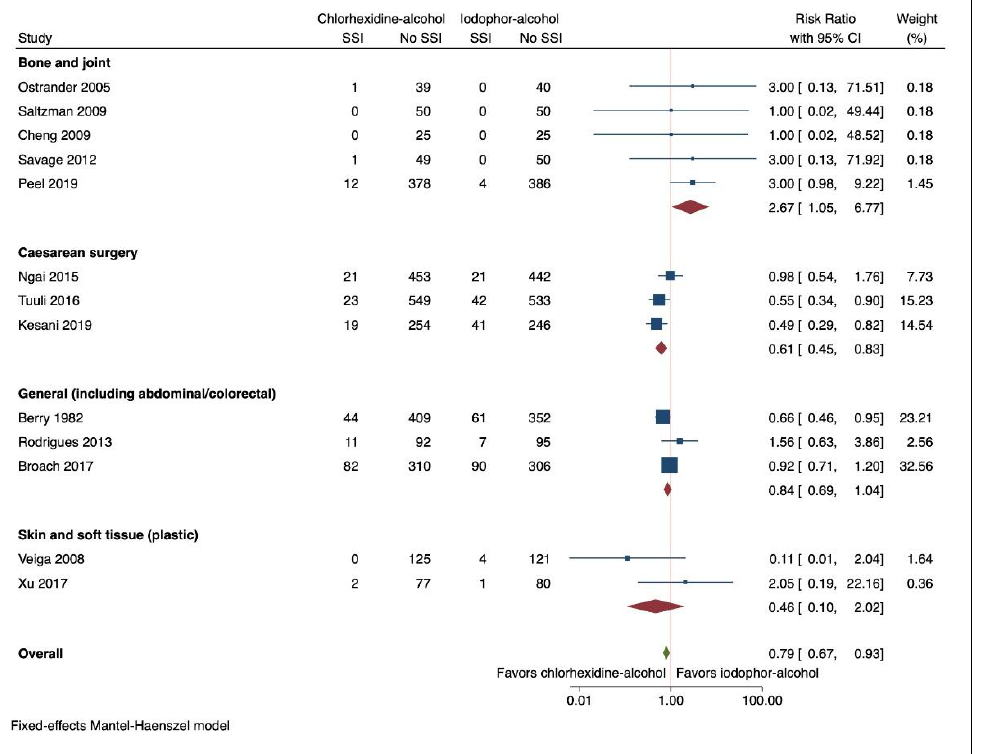
Figure 3 . Forest Plot Comparing Risk of Surgical Site Infection (SSI) with Chlorhexidine-Alcohol to Iodophor-Alcohol Surgical Site Skin Preparation According to Procedure Groups. Navy square represents the effect estimates from the individual studies, the size of the square is proportional to the weight of the study. The horizontal line represents the 95% confidence interval of the study estimate. The red diamond represents the pooled effect size for the specified procedure group. The green diamond represents the pooled effect size.